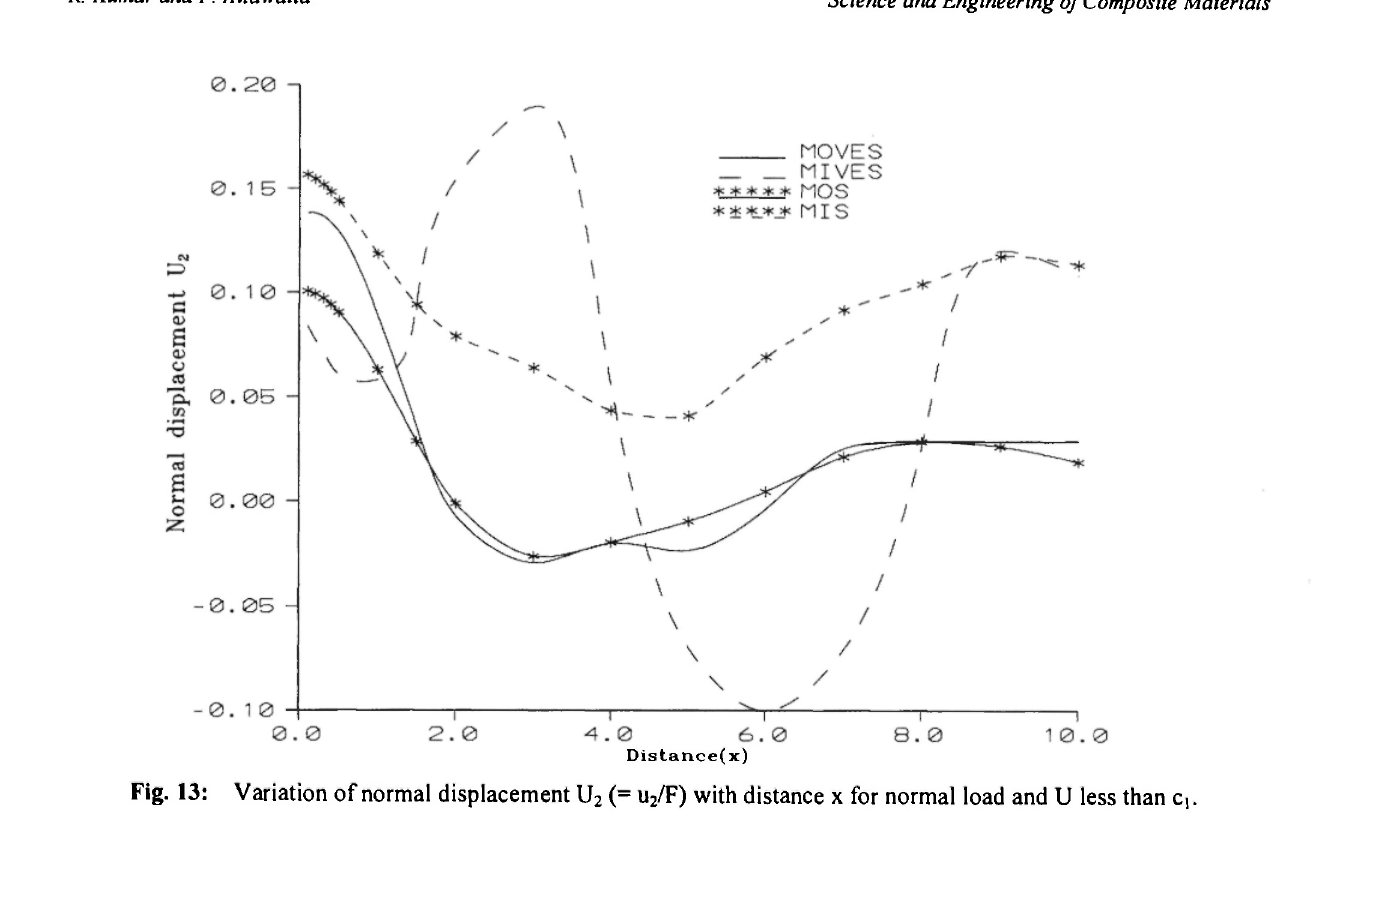
Fig. 13: Variation of normal displacement U 2 (= u 2 /F) with distance χ for normal load and U less than q.